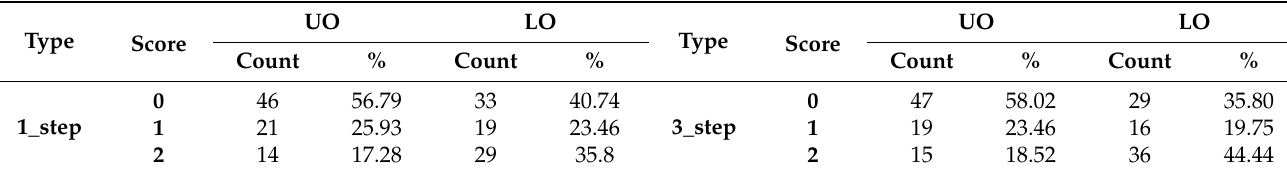
Table 3. Frequency tables of jump shot precision parameters.